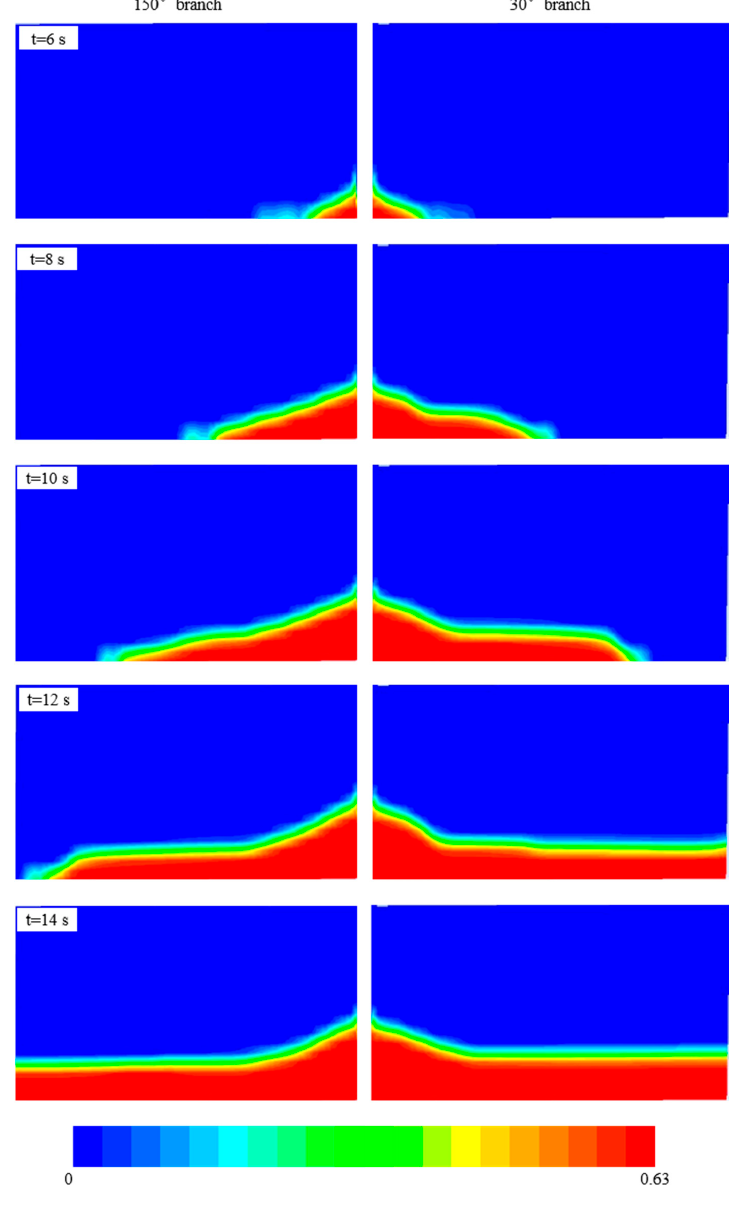
◦ - and 150 ◦ -branches under a low pumping Figure 15. Dune development in 30°- and 150°-branches under a low pumping rate. Figure 15. Dune development in 30